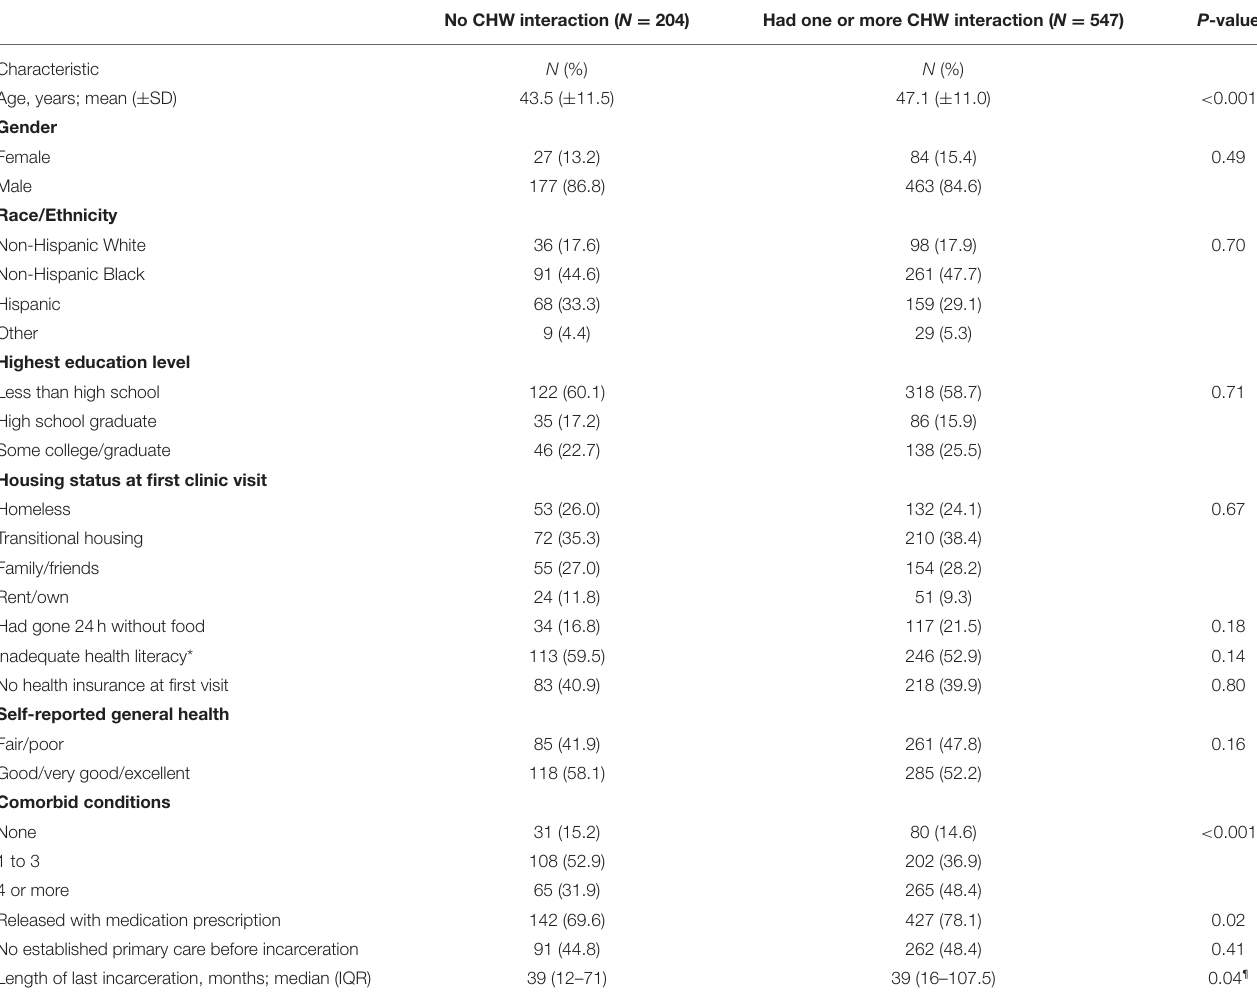
TABLE 1 | Participant characteristics and CHW interactions outside of the primary care clinic ( N = 751). No CHW interaction ( N =